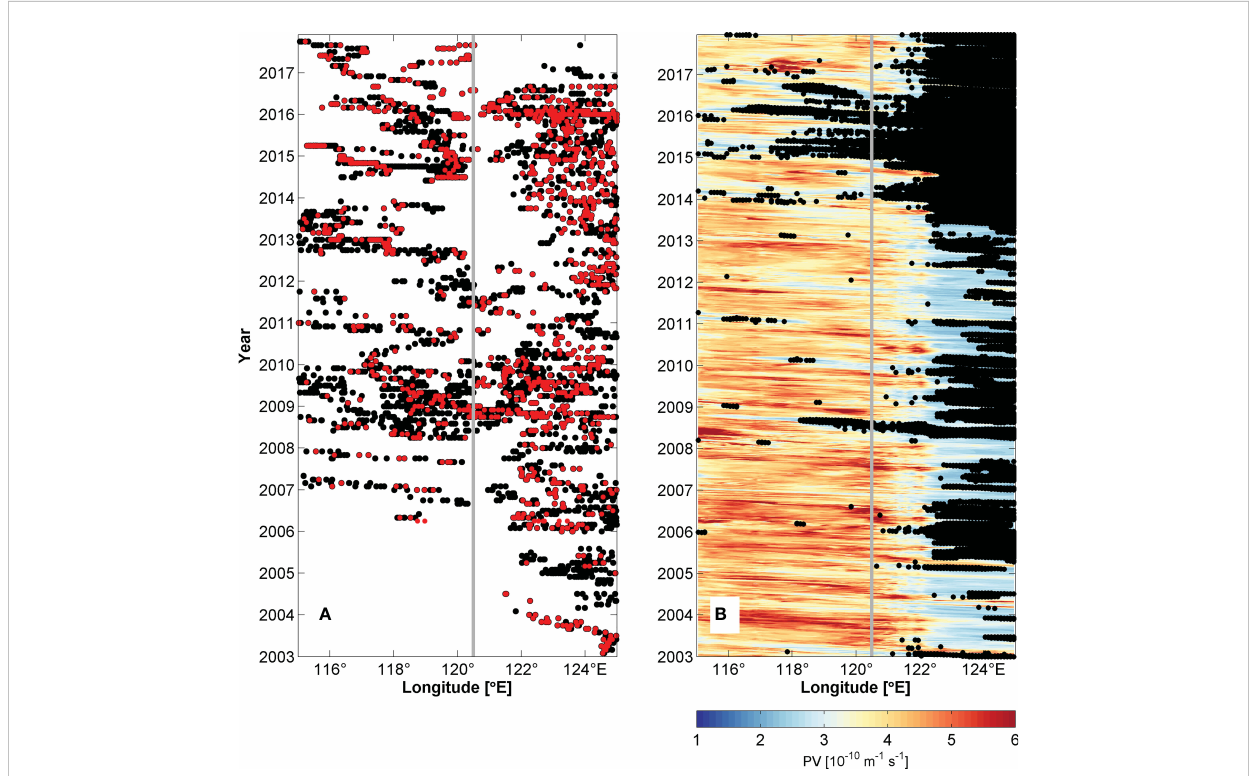
FIGURE 3 Time – longitude plots averaged over 19° – 23°N of (A) Argo pro fi le distribution (black dots) on both sides of the Luzon Strait and (B) OFES PV distribution averaged within the STMW layer. The red (black) dots in Figure 2A (Figure 2B) indicate the occurrence of a low PV signal (PV < 2 (cid:1) 10 − 10 m − 1 · s − 1 ) in the STMW core layer. There are a total of 3279 Argo pro fi les (black dots) with 2840 (red dots) capturing low PV signals in Figure 2A. The gray lines indicate the location of the LS at